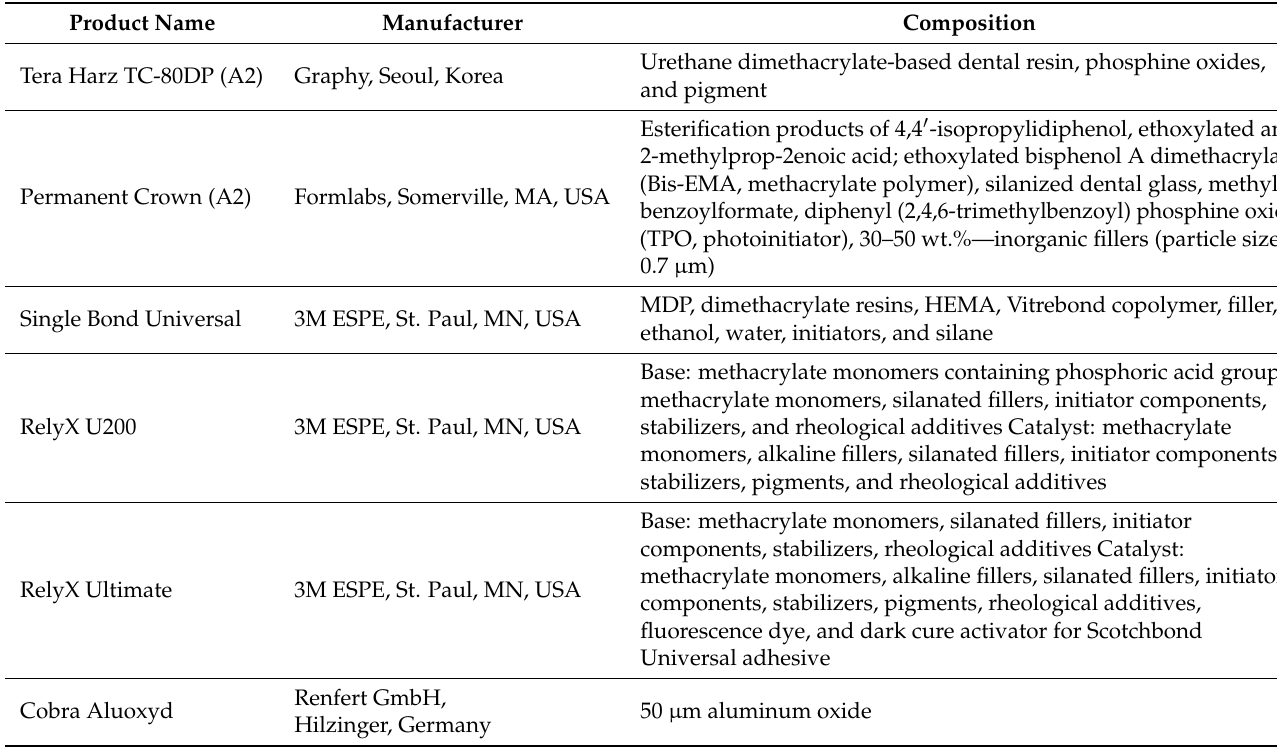
Table 1. Composition of materials used in this study.